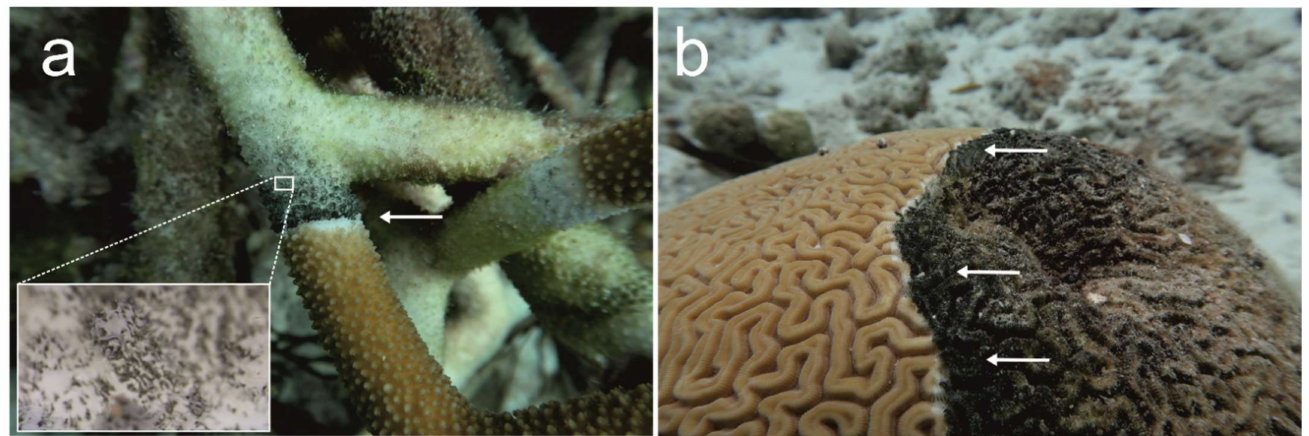
Figure 1. It shows the typical appearance of corals affected by CCI. The arrows indicate the cluster of ciliates forming CCI dark-grey bands located at the interface between recently exposed skeleton and apparently healthy coral tissue on ( a ) Acropora cervicornis and ( b ) Diploria labyrinthiformis